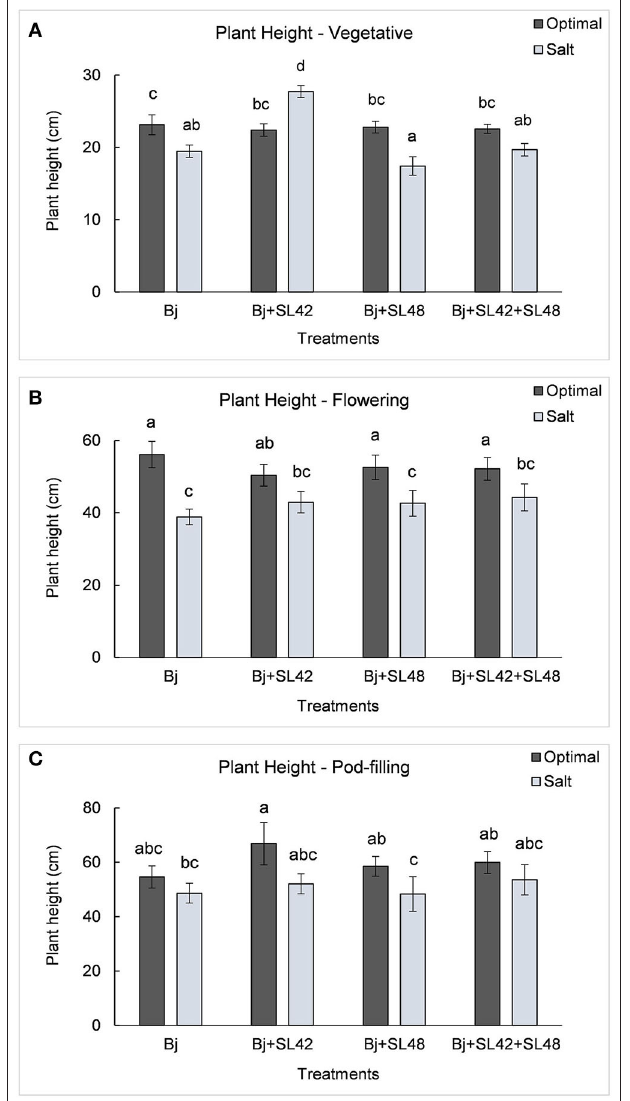
FIGURE 7 | Leaf area of soybean plants measured at (A) mid-vegetative, (B) mid-flowering, and (C) mid-pod-filling stages under optimal (water) and salt (150mM NaCl) conditions. The seeds were bacterized with Bradyrhizobium japonicum (Bj), Bj + SL42, Bj + SL48 and Bj + SL42 + SL48. Values represent mean ± SE ( n = 12). Scheffe grouping for least square means was used for multiple means comparison and means with the same letter(s) are not significantly different ( α =